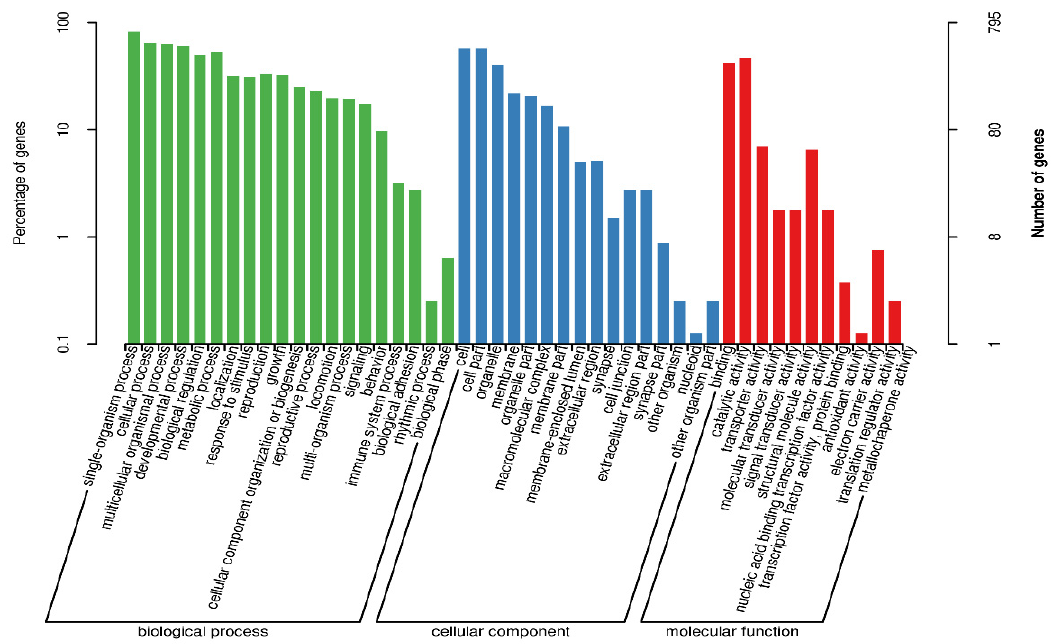
Figure 6. Statistical map of GO annotation classification of Up-regulate DEGs.